Question: What caption would you write for this figure?
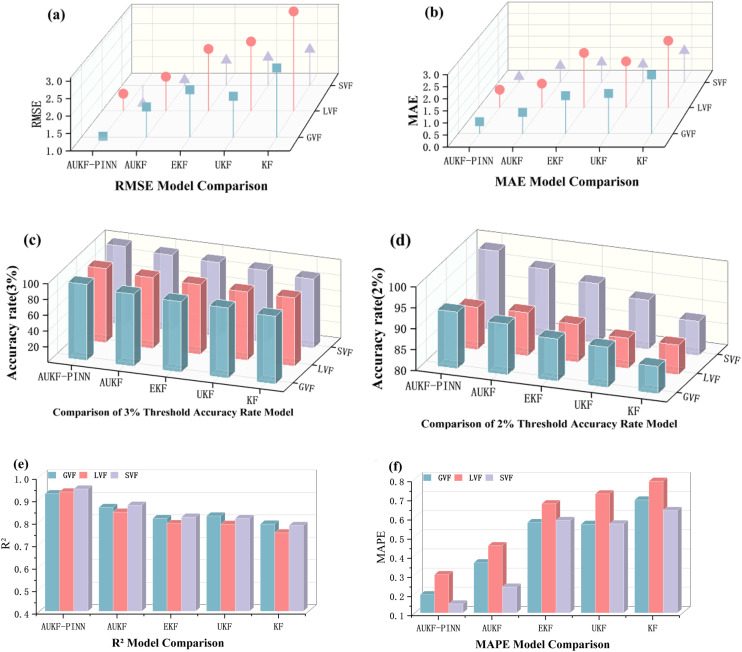
Answer: Model Performance Comparison Chart.